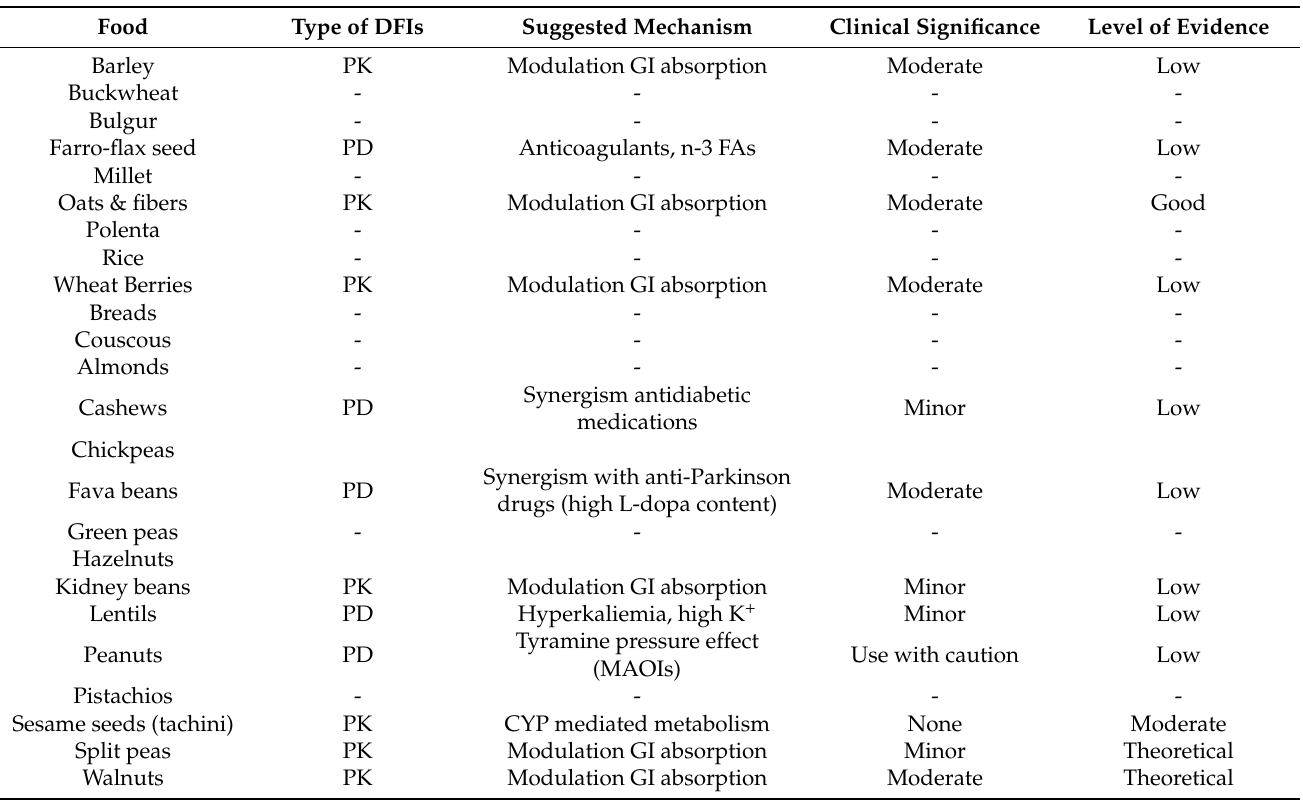
Table 3. DFIs, pharmacological mechanism, significance, and level of evidence for nuts, and cereals that are contained in the base of Med-D